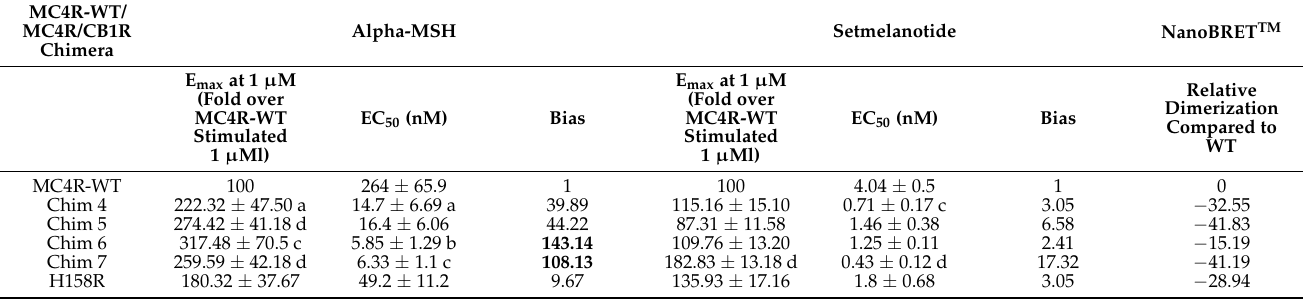
(Figure 4). All tested MC4R/CB1R chimeras showed similar basal G q/11 activity compared to MC4R-WT. Chim 4, Chim 5, Chim 6, and Chim 7 exhibited significantly elevated PLC ac- tivation via G q/11 after alpha-MSH stimulation (1 µ M). The mutation H158R also exhibited higher efficacy (Emax) compared to MC4R-WT. Setmelanotide stimulation only led to a sig- nificant increase in efficacy for Chim 7, compared to MC4R-WT (Figure 4A). Table 1 shows the evaluation of chimeric receptor G q/11 signaling capacities compared to MC4R-WT after challenge with alpha-MSH or setmelanotide. The values are derived from concentration response experiments (Figure 4B–E). Reduced homodimerization results in a prominent effect on receptor potency. Intriguingly, EC 50 values of Chim 6 (5.85 ± 1.29 nM) and of Chim 7 (6.33 ± 1.1 nM) after alpha-MSH stimulation were similar to EC 50 of MC4R-WT after setmelanotide challenge (4.04 ± 0.5 nM). Of note, all chimeric receptors as well as the H158R mutation presented improved potency, compared to MC4R-WT EC 50 value after alpha-MSH and after setmelanotide stimulation. Significant decrease in potency could be shown for Chim 4, Chim 6, and Chim 7 after alpha-MSH stimulation and for Chim 4 and Chim 7 after setmelanotide challenge, compared to MC4R-WT. The effects of impaired MC4R homodimerization on G q/11 signaling were also assessed through calculating the signaling bias. In particular, after alpha-MSH stimulation, all chimeric receptors and the H158R mutation showed a strong bias towards PLC activation compared to MC4R-WT. Chimeric receptors and H158R mutation also demonstrated a bias towards PLC activation after challenge with setmelanotide (Table 1). Table 1. Efficacy (E max ), potency (EC 50 ), and bias of ligand stimulated MC4R-WT, chimeric recep- tors, and H158R. Concentration–response curves were used to determine potency under alpha-MSH and setmelanotide stimulation. Data are given as the result of four to nine independent experiments performed in triplicate. Values represent mean ± SEM. Statistical analysis was performed using a one-way ANOVA with Kruskal–Wallis test comparing E max of WT to variants or EC 50 of WT to the variants. Statistical significance is indicated by a * p < 0.05, b ** p < 0.01, c *** p < 0.001, and d **** p < 0.0001. For calculation of bias, MC4R-WT serves as a reference and is plotted at a value of 1. The bias (chimeras versus MC4R) is stronger after alpha-MSH stimulation than after setmelanotide stimulation. The values are derived from EC 50 and E max values and originate from the concentration– response curves. Data are given as a result of four to nine independent experiments performed